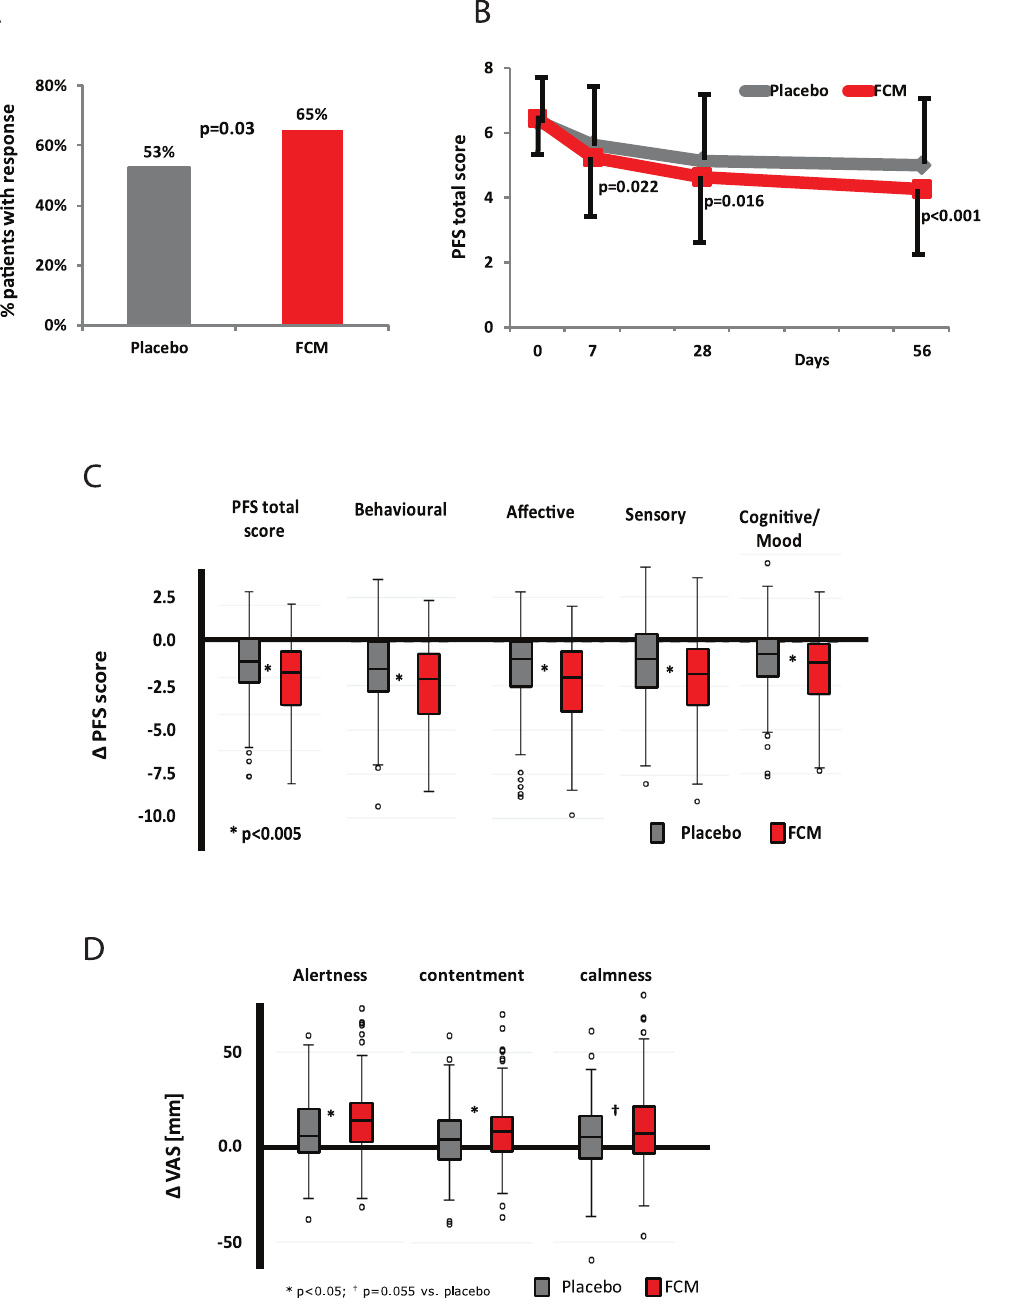
Figure 2. Treatment effects of FCM vs. placebo in fatigued, iron-deficient, non-anemic women (ITT; error bars SD). (A) Proportion of patients with $ 1 point reduction in PFS (primary endpoint). (B) Improvement of mean PFS total score in FCM- vs. placebo-treated patients throughout the study (Mean differences 6 SD vs. baseline: Day 7: 2 1.2 6 1.8 vs. 2 0.8 6 1.5 points; Day 28: 2 1.8 6 2.1 vs. 1.2 6 2.0 points; Day 56: 2 2.2 6 2.1 vs. 2 1.4 6 2.0 points). P-values given for intergroup differences. (C) Mean change ( D ) in PFS total score and subscale scores from baseline to Day 56. *P # 0.01 for all scales. (D) Mean change ( D ) in self-rated alertness, contentment and calmness (computer-based VAS scales). *P , 0.05; { P=0.055 vs. placebo.